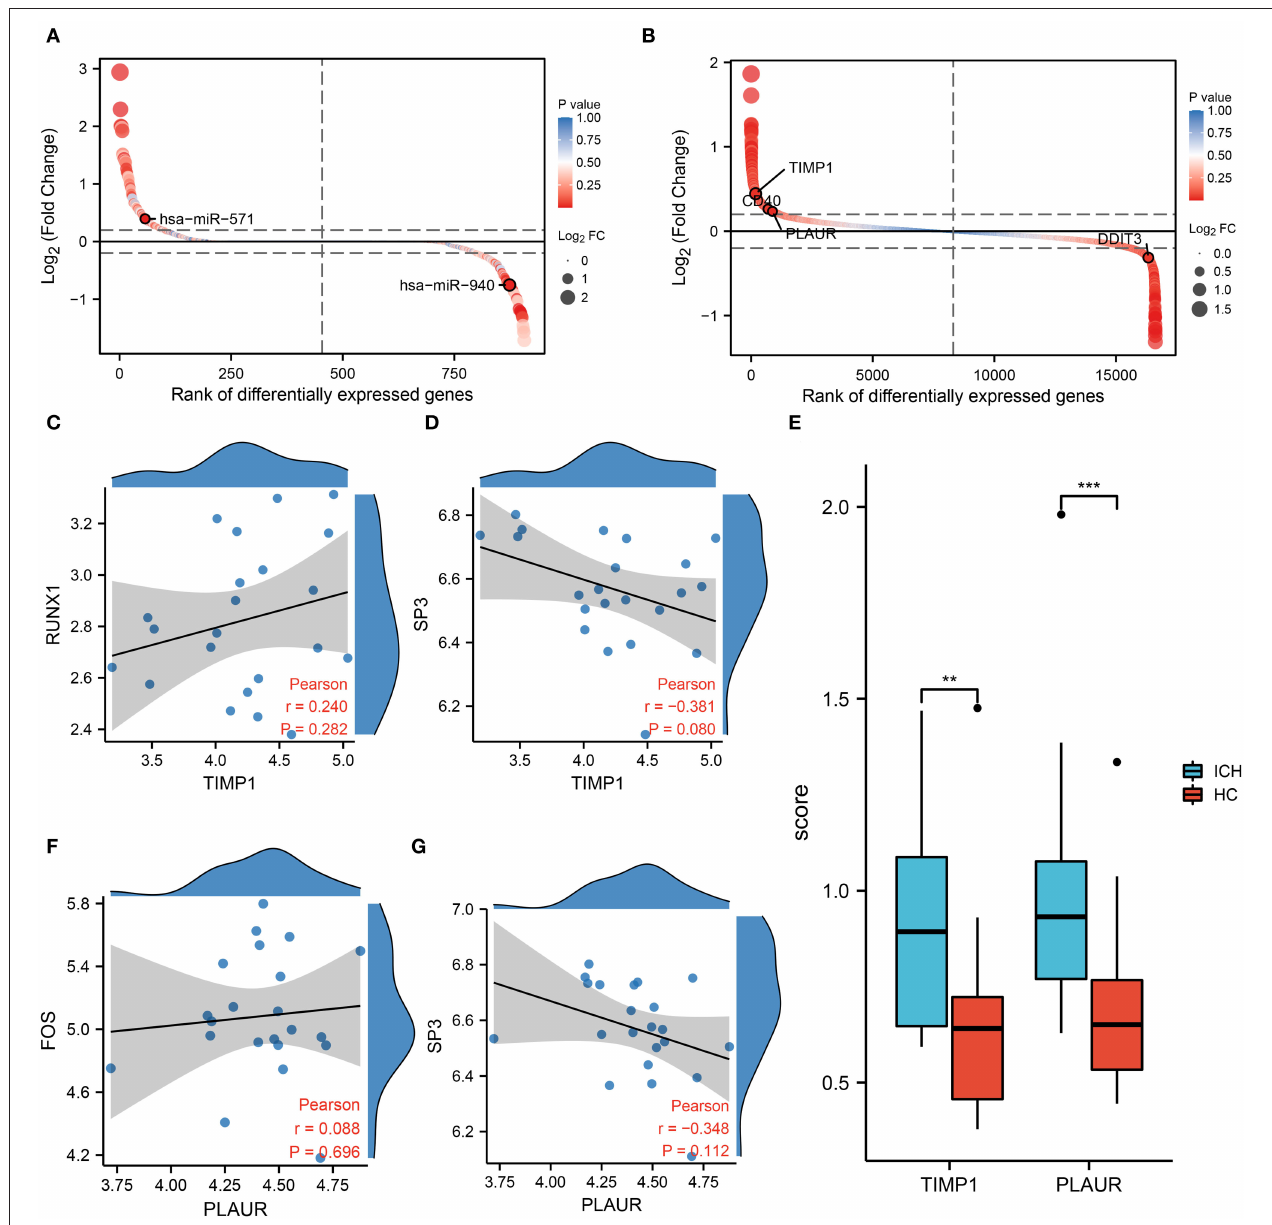
FIGURE 5 | Results of co-expression analysis of four core genes. DEmiRNAs (A) DEmRNAs (B) are arranged by log 2 (Fold Change). (C) Correlation analysis between RUNX1 and the inflammation-associated gene TIMP1 . (D) Correlation analysis between SP3 and the inflammation-associated gene TIMP1 . (E) PCR showed differential expression of TIMP1 and PLAUR between the HC and ICH groups. (F) Correlation analysis between FOS and PLAUR. (G) Correlation analysis between SP3 and PLAUR.